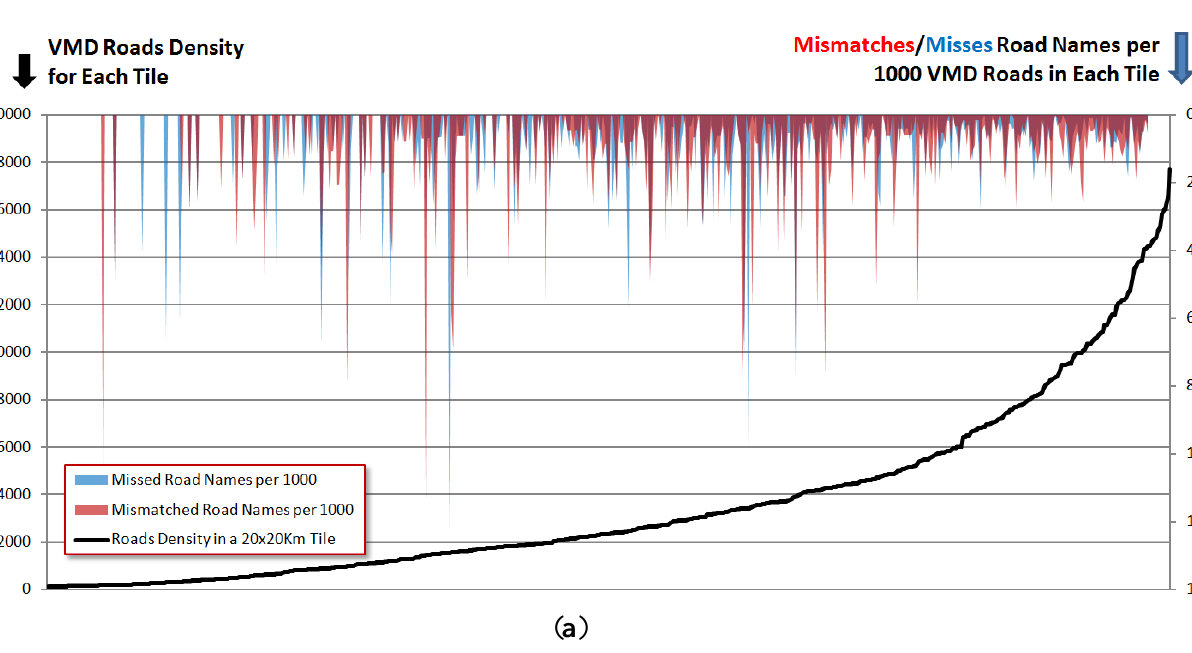
Figure 9. The comparison of the patterns of road names bug ratios and the road densities. The x-axis indicates the tiles sorted by the roads density. The dropping down peaks show the two types of bug ratios. Upper plot ( a ): bug ratios for the road name; lower plot ( b ): bug ratios for the road references. Red: mismatched attributes; blue: missing